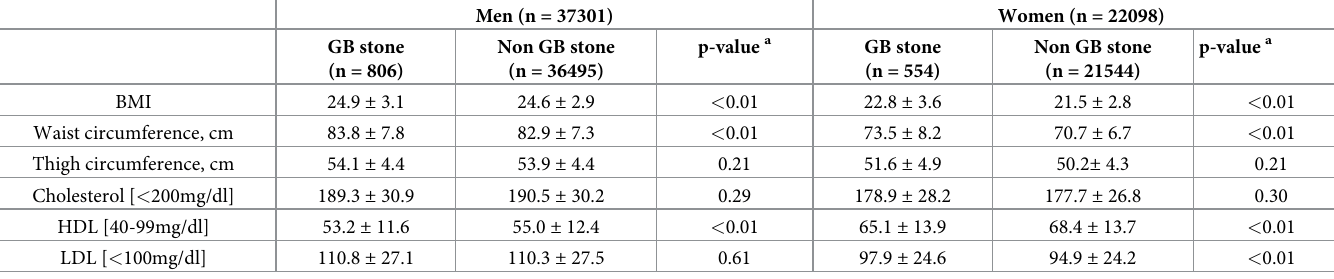
Table 5. Comparison of the GB stone group and non-GB stone group among young